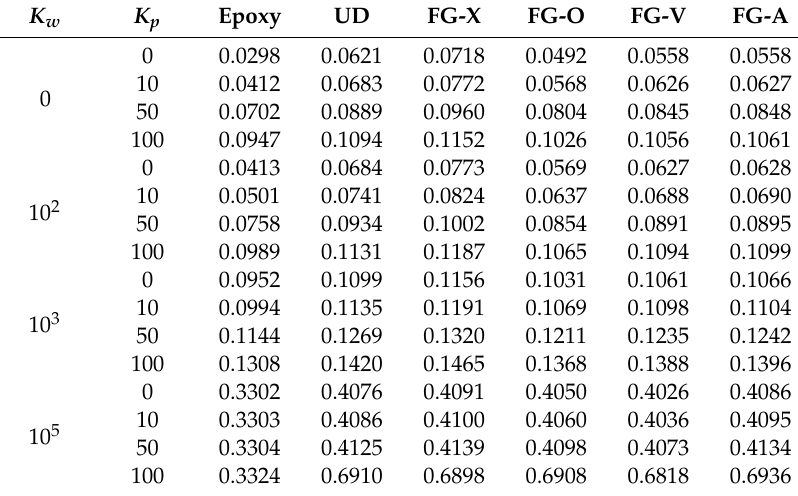
Table 5. The e ff ects of an elastic foundation on the fundamental frequency Ω of FG-GPLRC beams ( λ = 1 / 10, M x = M y = M z =